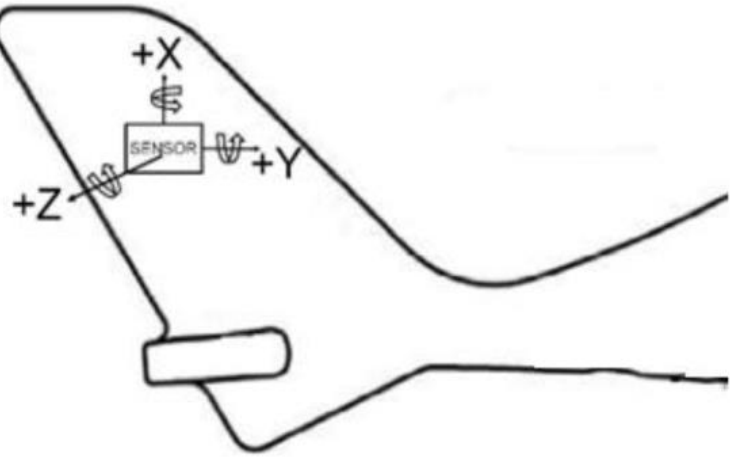
Figure 2. Accelerometer diagram placed in the wind turbine.